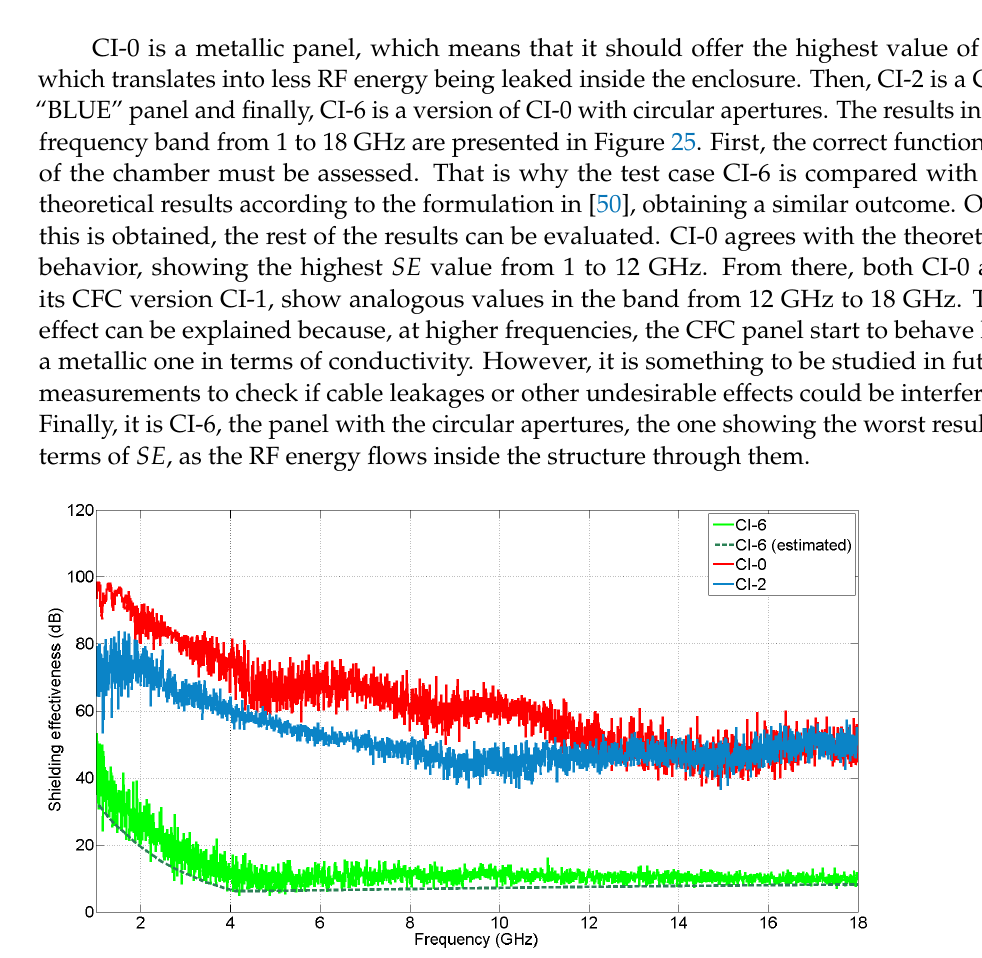
Figure 25. Shielding effectiveness measurement according to IEC 61000-4-21 standard.